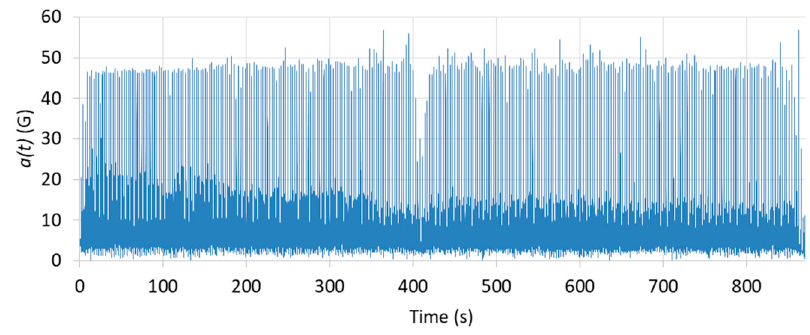
Figure 4. Acceleration modulus a ( t ) for one CrossFit Figure 4. Acceleration modulus 𝑎(cid:4666)𝑡(cid:4667) for one CrossFit athlete. Figure 4. Acceleration modulus 𝑎(cid:4666)𝑡(cid:4667) for one CrossFit athlete.